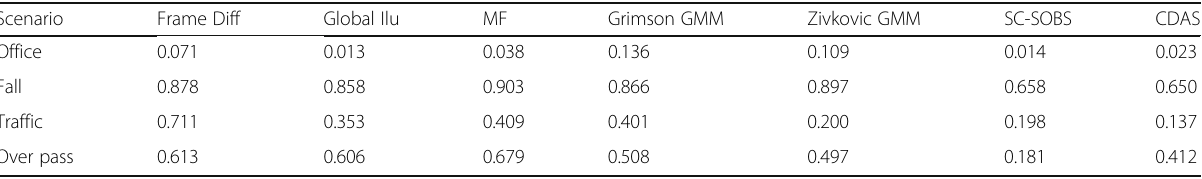
Table 6 Comparisons of FNR of the competing methods over tested scenarios Scenario